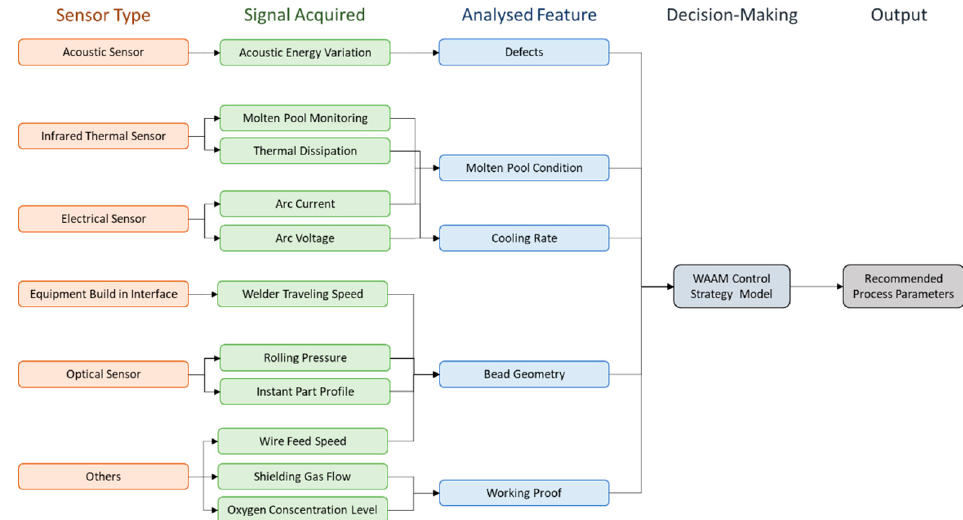
Figure 32. Schematic diagram of a full monitoring system for WAAM (adapted from [148]).